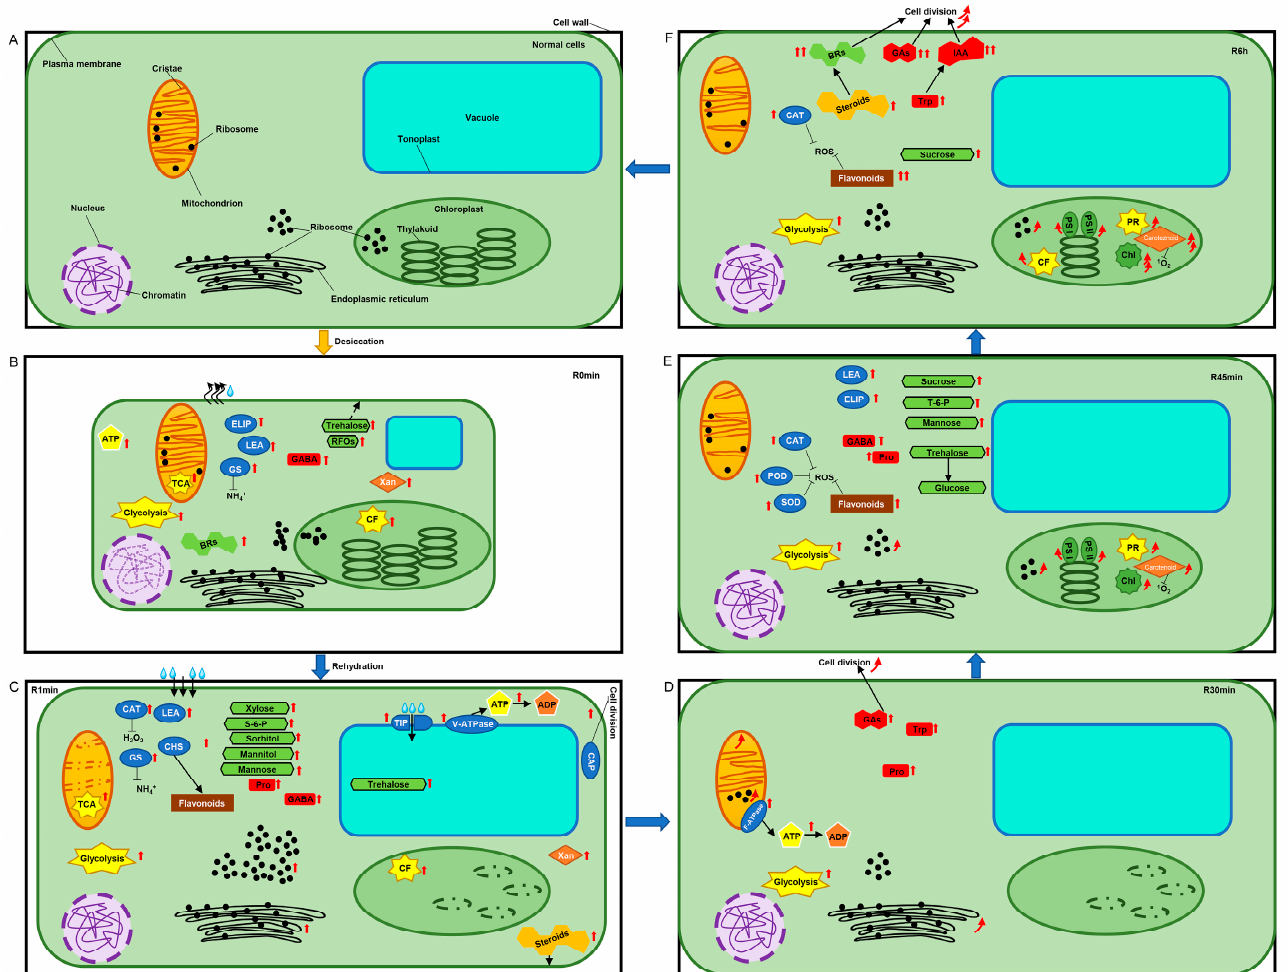
Figure 7. Proposed model of dehydration and rehydration processes in R. canescens . ( A ) normal condition before desiccation; ( B ) desiccated state; ( C ) 1 min of rehydration; ( D ) 30 min of rehydra-